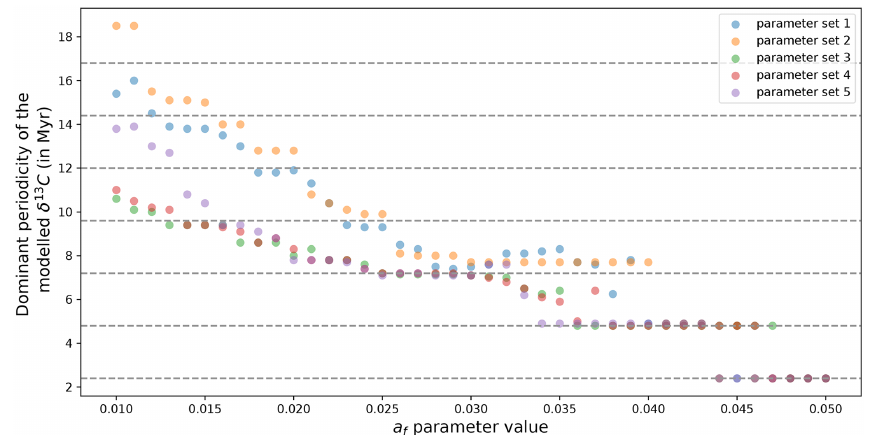
Figure 10. Dominant period of the modelled δ 13 C as a function of the a f value for different parameter sets.